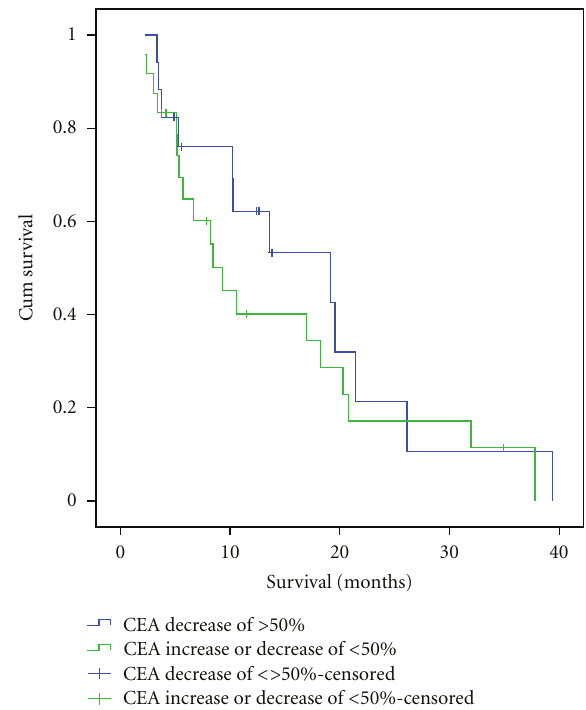
Figure 3: Kaplan-Meier survival curve comparing those with CEA response, as indicated by a decrease of ≥ 50% from baseline, to those who did not have a CEA response posttreatment. The estimated median survival was 19.1 months for those with a CEA response compared to 9.3months. This di ff erence was not found to be significant when using log-rank analysis P - value of